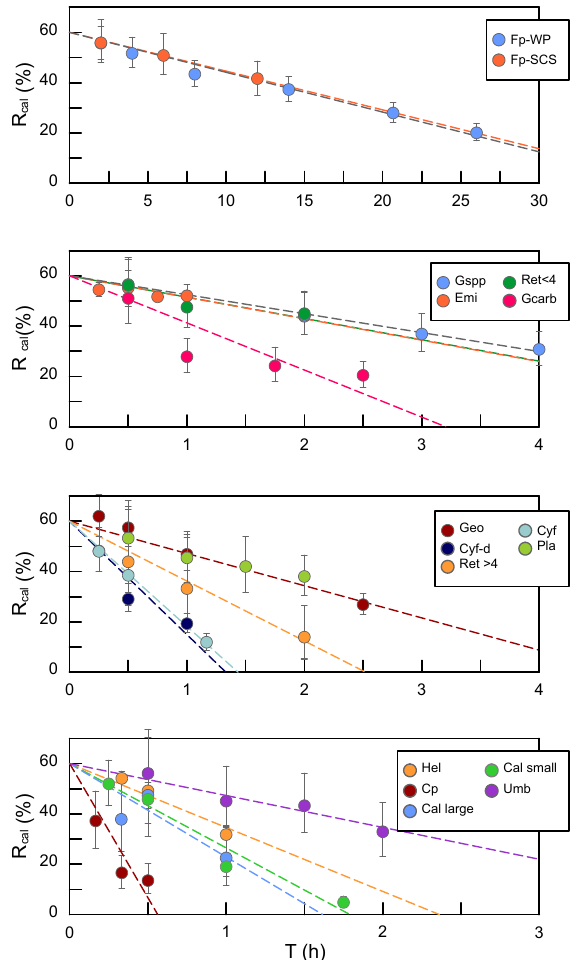
Figure 5. The calibrated ratio ( R cal ) vs. sinking duration. Fp-WP means F. profunda in the West Pacific. Fp-SCS means F. pro- funda in the South China Sea. Emi means E. huxleyi . Gspp means small Geophyrocapsa . Geo means G. oceanica . Gcarb means